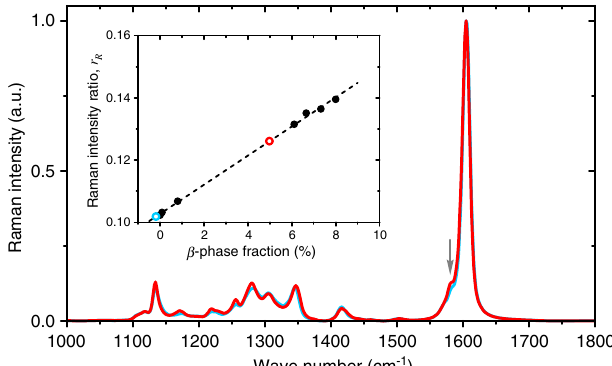
FIG. 20. Estimation of β -phase vol% in HMW TOF (i.e., optically thick) layers using glassy (blue line) and β -phase embedded (red line) Raman spectra. A grey arrow indicates the spectral position of the 1581 cm − 1 mode. The inset shows the previously reported [67] experimental data and linear fit (filled circle and dashed line, respectively) for the Raman intensity ratio r of the 1581 cm − 1 mode relative to the 1606 cm − 1 mode as a R function of the β -phase fraction. The corresponding r extracted from the Raman spectra of glassy (blue open circle) and β -phase embedded (red open circle) TOF PFO films are placed on the fit line to provide estimates for their respective β -phase fractions.